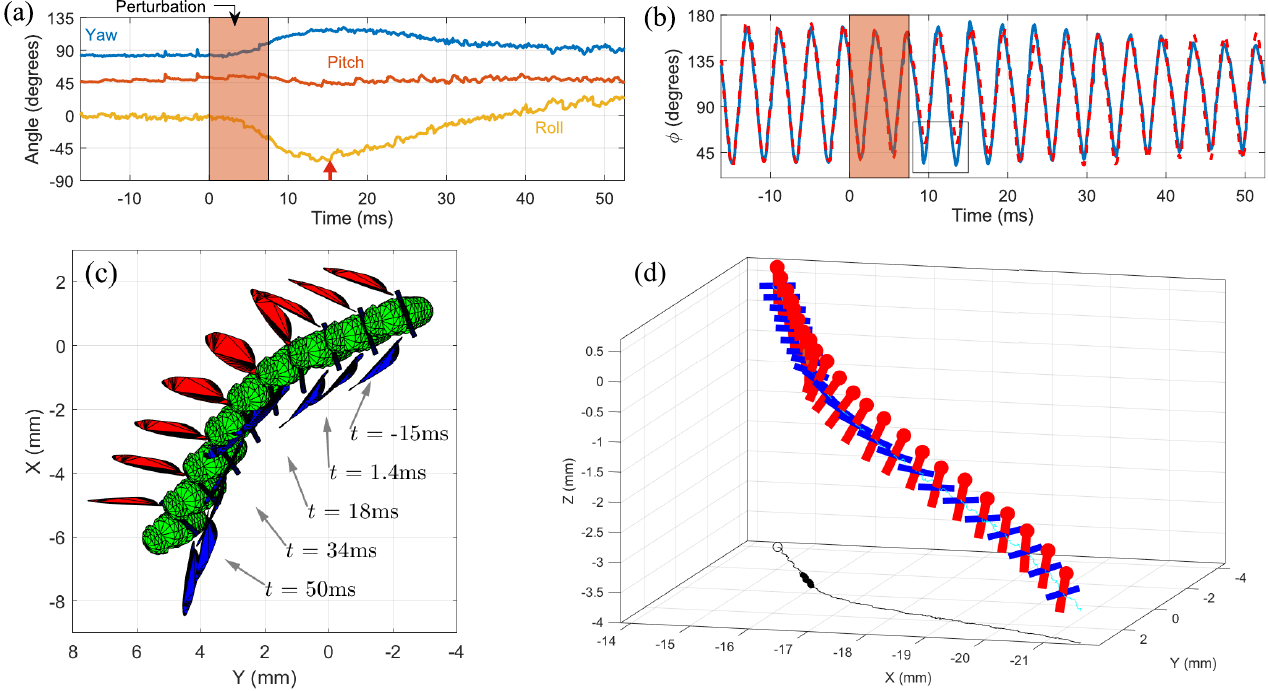
Figure 12. Roll correction. ( a ) Body angles during the maneuver. Magnetic pulse was activated between t = 0 − 7.5 ms. An orange vertical arrow marks the time of maximum angular deflection in roll, yaw and pitch. ( b ) Wings stroke angles. Blue line and red dashed line mark φ (cid:96) and φ r respectively. The rectangle marks the main wing asymmetry during the maneuver. ( c ) Top view of the fitted model shows every two wing beats when the left wing is at supination. Wing stroke asymmetry is clearly visible. ( d ) Flight trajectory and body pose plotted in 1 wingbeat intervals during the maneuver. The body x axis is plotted in red lines, with a red dot indicating the head, and the body y direction is represented by blue line. The trajectory starts at the top corner of the plotted box. A 2D projection of the trajectory is plotted on the xy plane (black line), with the time of the perturbation marked by a thicker